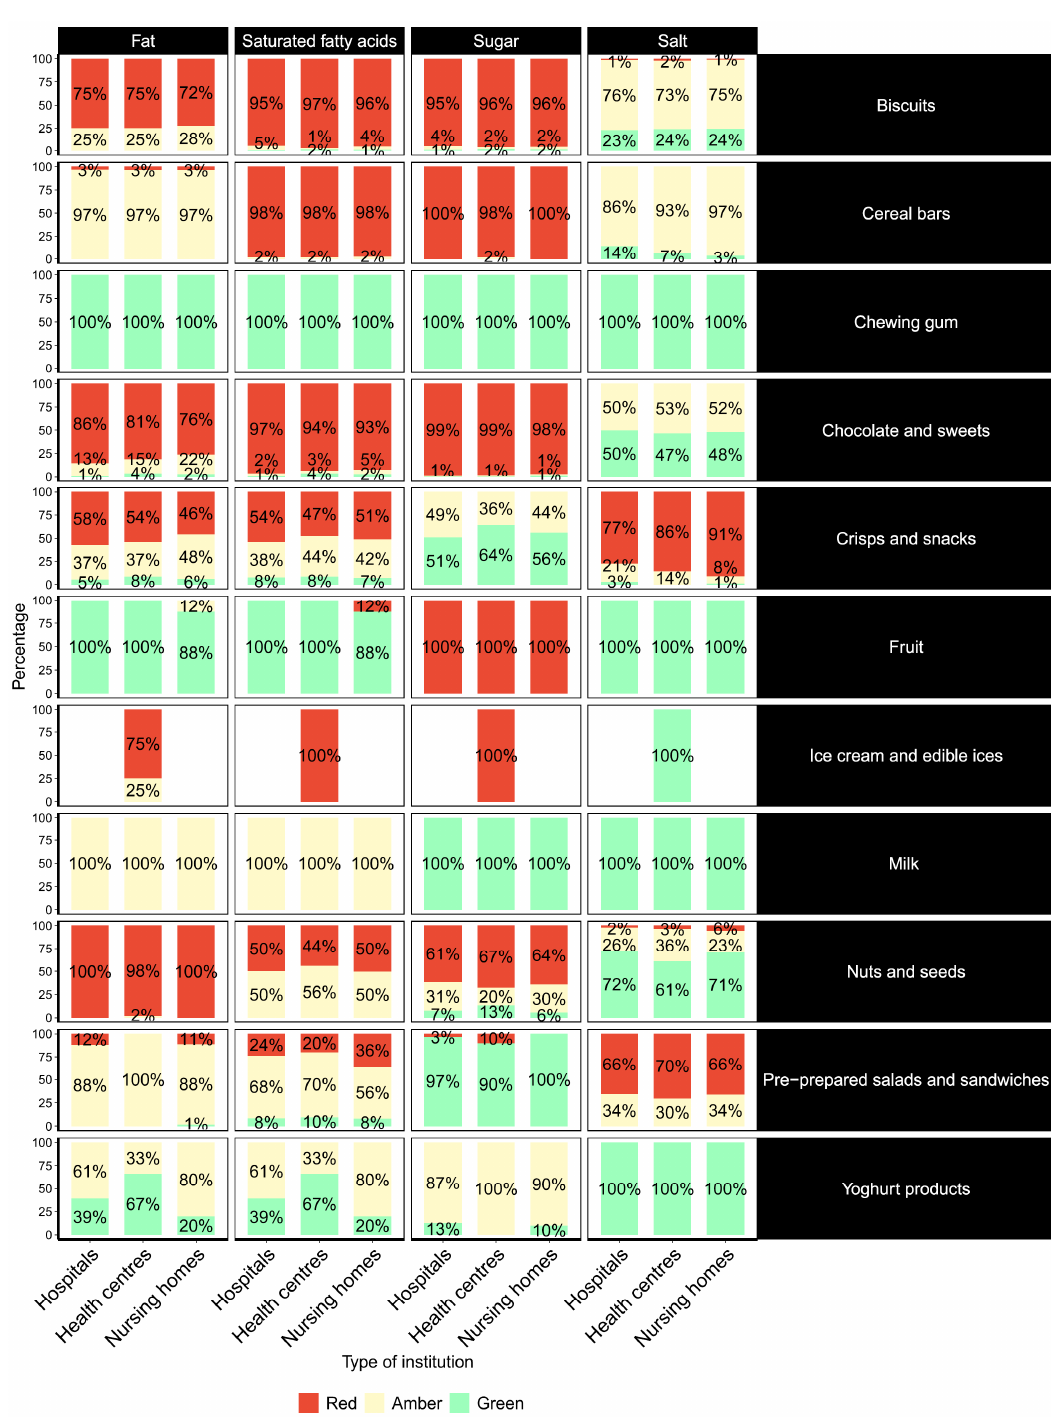
Figure 1. Percentage (%) of displayed foods (per food category) in the vending machines in health and social care institutions assessed as green/amber/red (food traffic light profiling).